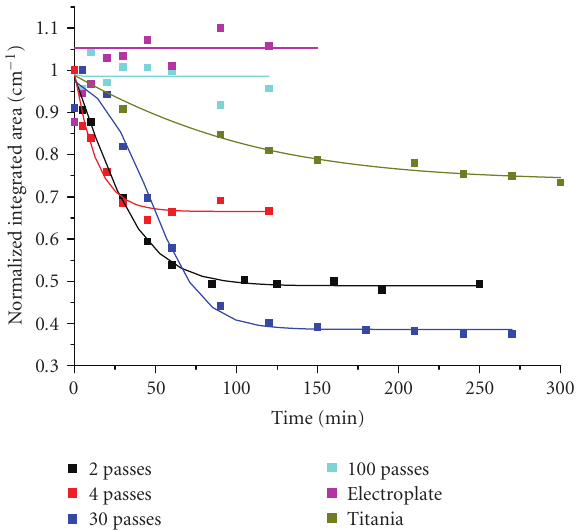
Figure 4: Visible photoactivity for Ag films of di ff ering thickness (2, 4, 30, and 100 passes). Also included are the results for the electroplate silver ( ) and an 80 nm thick film of titania ( ).